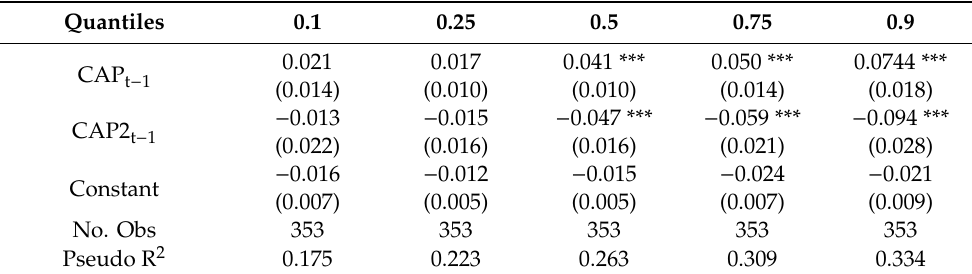
Table 9. The U-shaped relationship between capital ratio and